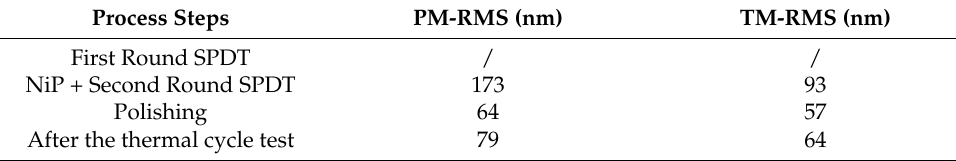
Figure 19. Surface-shape deviation results after the thermal cycle test: ( a ) PM; ( b ) TM. Table 5. Summary of mirror surface shape under different